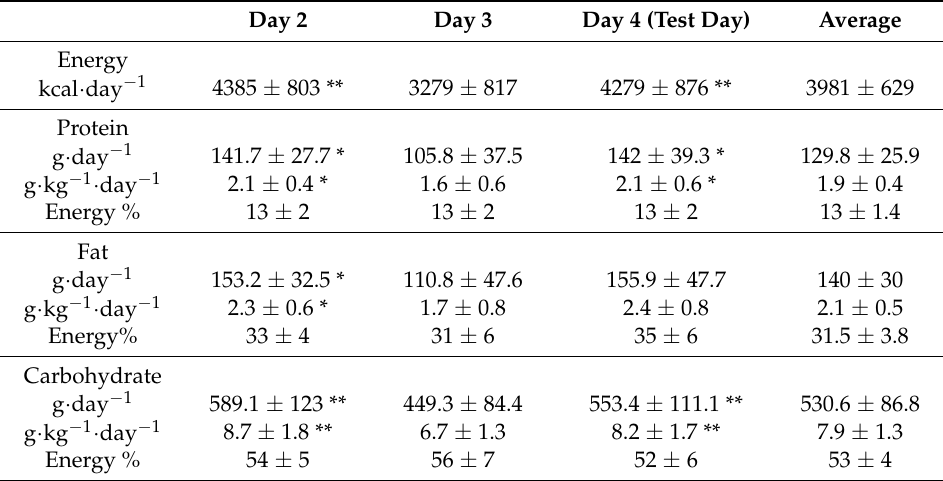
Table 3. Average daily energy intake and macronutrient